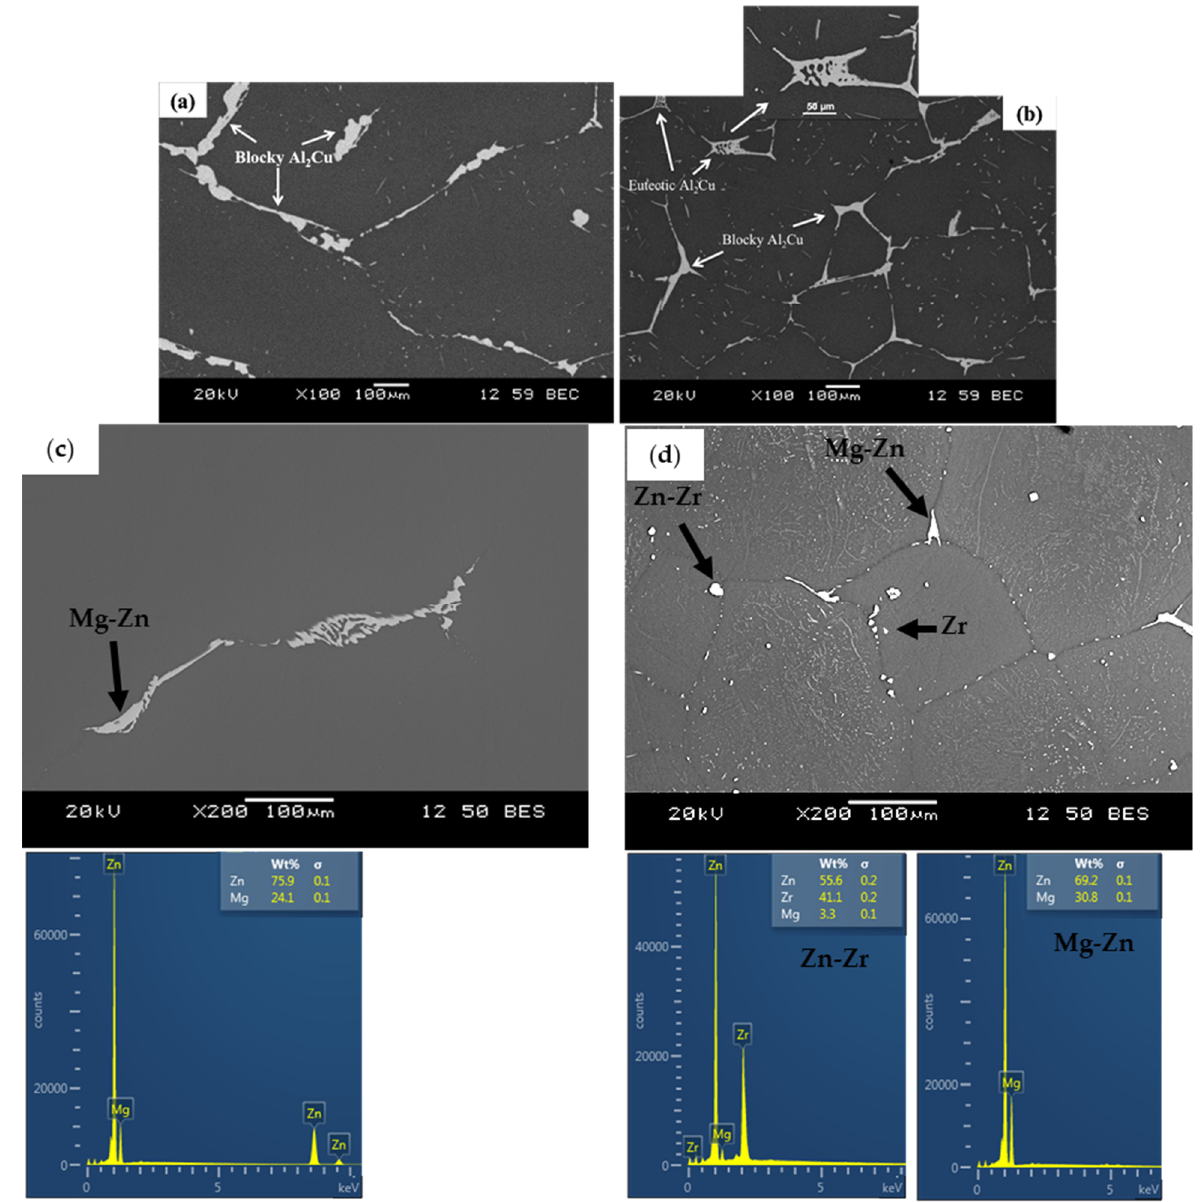
Figure 3. SEM images of ( a ) Al-Cu, ( b ) Al-Cu-05Ti, ( c ) Mg-Zn and ( d ) Mg-Zn-Zr alloys after in-situ neutron diffraction experiments.